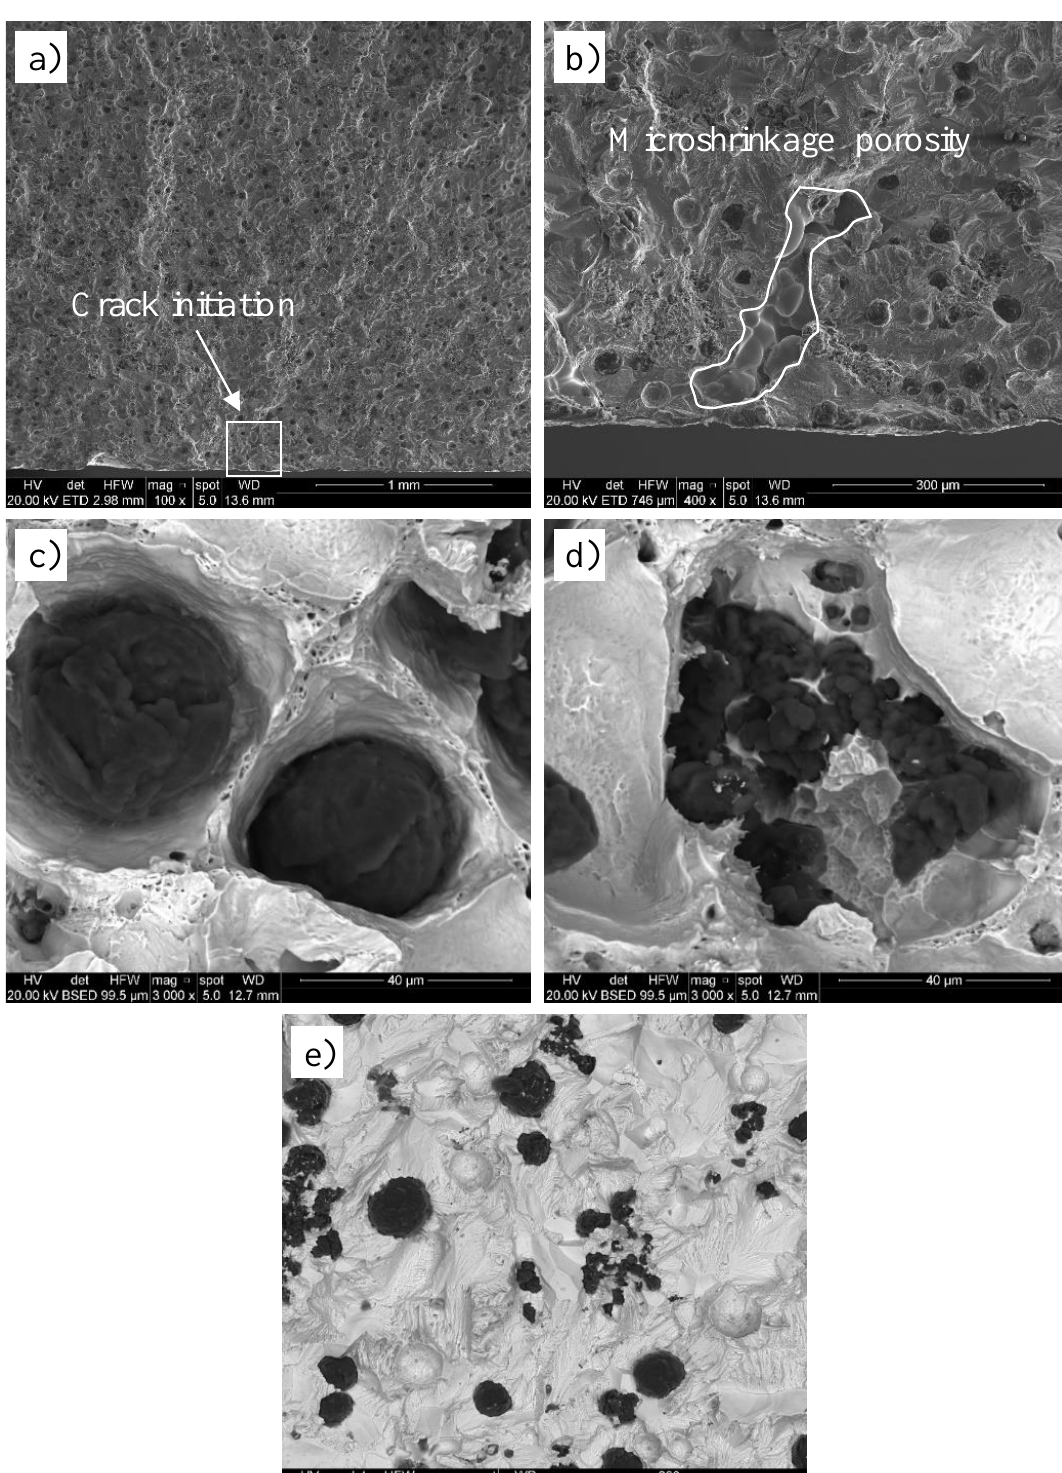
Figure 10. Scanning electron microscope (SEM) images of fracture surfaces showing a panoramic overview of the crack initiation and propagation zone ( a ) and a particular of the crack initiating defect (microshrinkage porosity) ( b ); dimple fracture with microvoids coalescence in the presence of spheroidal graphite nodules ( c ) and degenerated graphite particles ( d ); image of the coexistence of brittle transgranular cleavage and intergranular fracture ( e ).